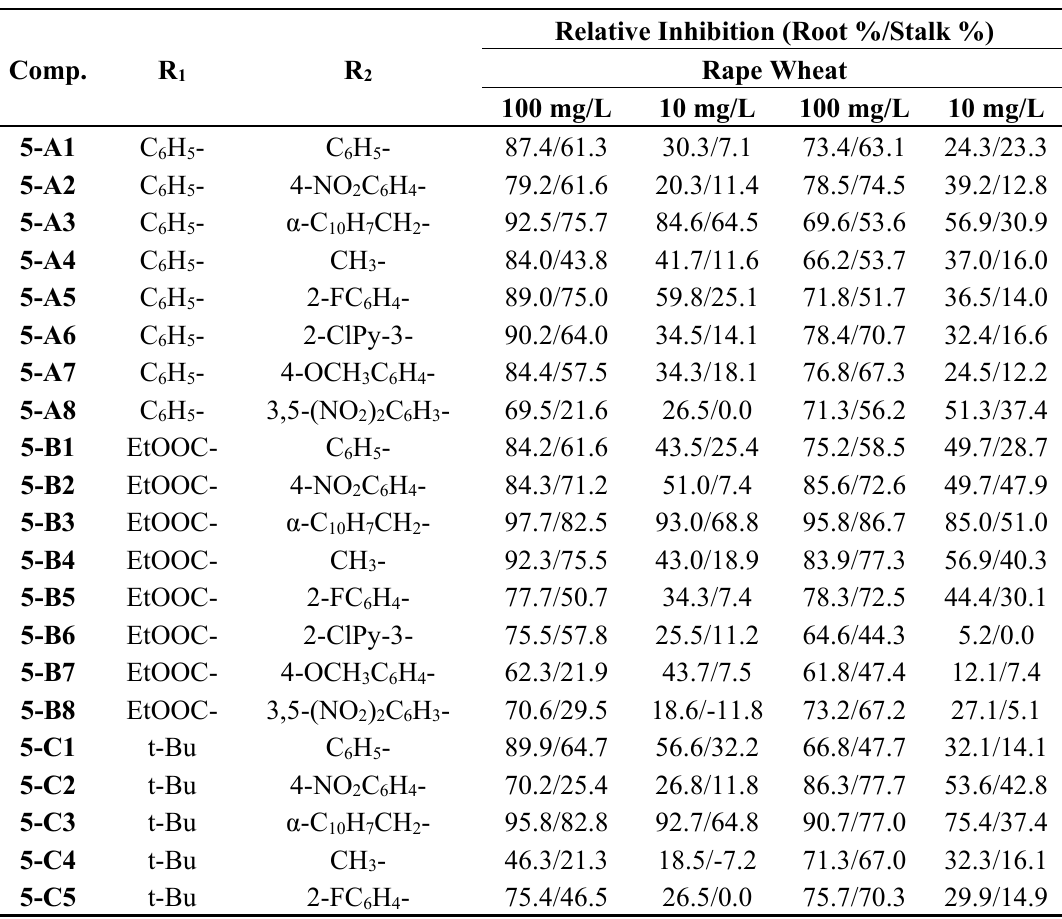
Table 1. The percent inhibitory ratios against the growth of root and stalk of wheat and rape of 5 at different